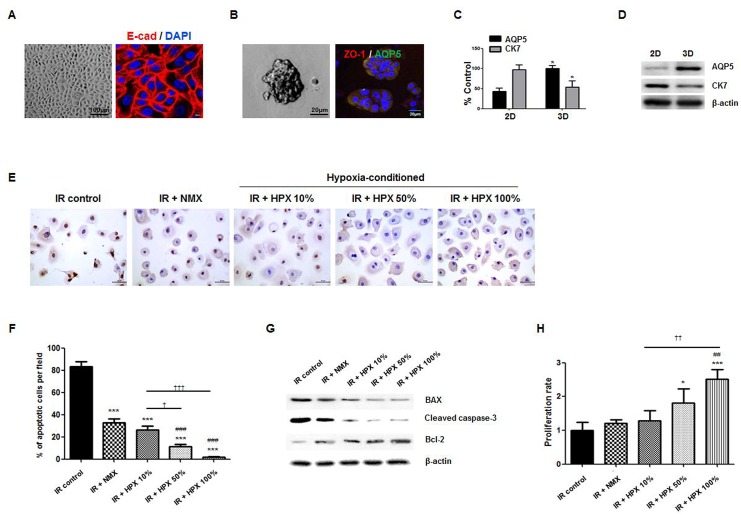

In vitro effect of the hAdMSC secretome on cell death and proliferation of human parotid epithelial cells (HPEC) treated with the hAdMSC secretome at concentrations of 10, 50 and 100% or a normoxic control medium.(A–B) Light microscopic and immunofluorescent staining of HPEC. Scale bars represent 100 and 8μm in A and 100 and 20 μm in B. (C-D) Salivary epithelial genes of AQP5 and CK7 were confirmed by real-time PCR and western blot. *, compared to 2D, *P < 0.05. (E) Anti-apoptotic effect was confirmed by an in vitro TUNEL assay in HPEC. (F) The number of fragmented DNA of HPEC according to the concentration of hAdMSC-cultured medium was determined in the same manner. Data are presented as the mean number of apoptotic cells per field ± SEM. One-way ANOVA, Tukey’s pot hoc test. *, compared to 0%; #, compared to IR + PBS; †, compared to IR + NMX. ***P < 0.001, ###P < 0.001, †P < 0.05, †††P < 0.001. 0%, control standard medium. (G) IR-induced changes in Bax, cleaved caspase-3 and Bcl-2 in HPEC treated with the hypoxia-cultured hAdMSC medium at concentrations of 10, 50 and 100% or a normoxic control medium for 72 hours were evaluated using Western blot. (H) Cell proliferation of HPEC was assessed in triplicate using a CCK-8. Data are presented as the mean number of cells per field ± SEM. One-way ANOVA, Tukey’s pot hoc test. *, compared to 0%; #, compared to IR + PBS; †, compared to IR + NMX. *P < 0.05, ***P < 0.001, ##P < 0.01, ††P < 0.01; IR + NMX, IR + normoxia-cultured hAdMSC medium, IR + HPX, hypoxia-conditioned hAdMSC medium.